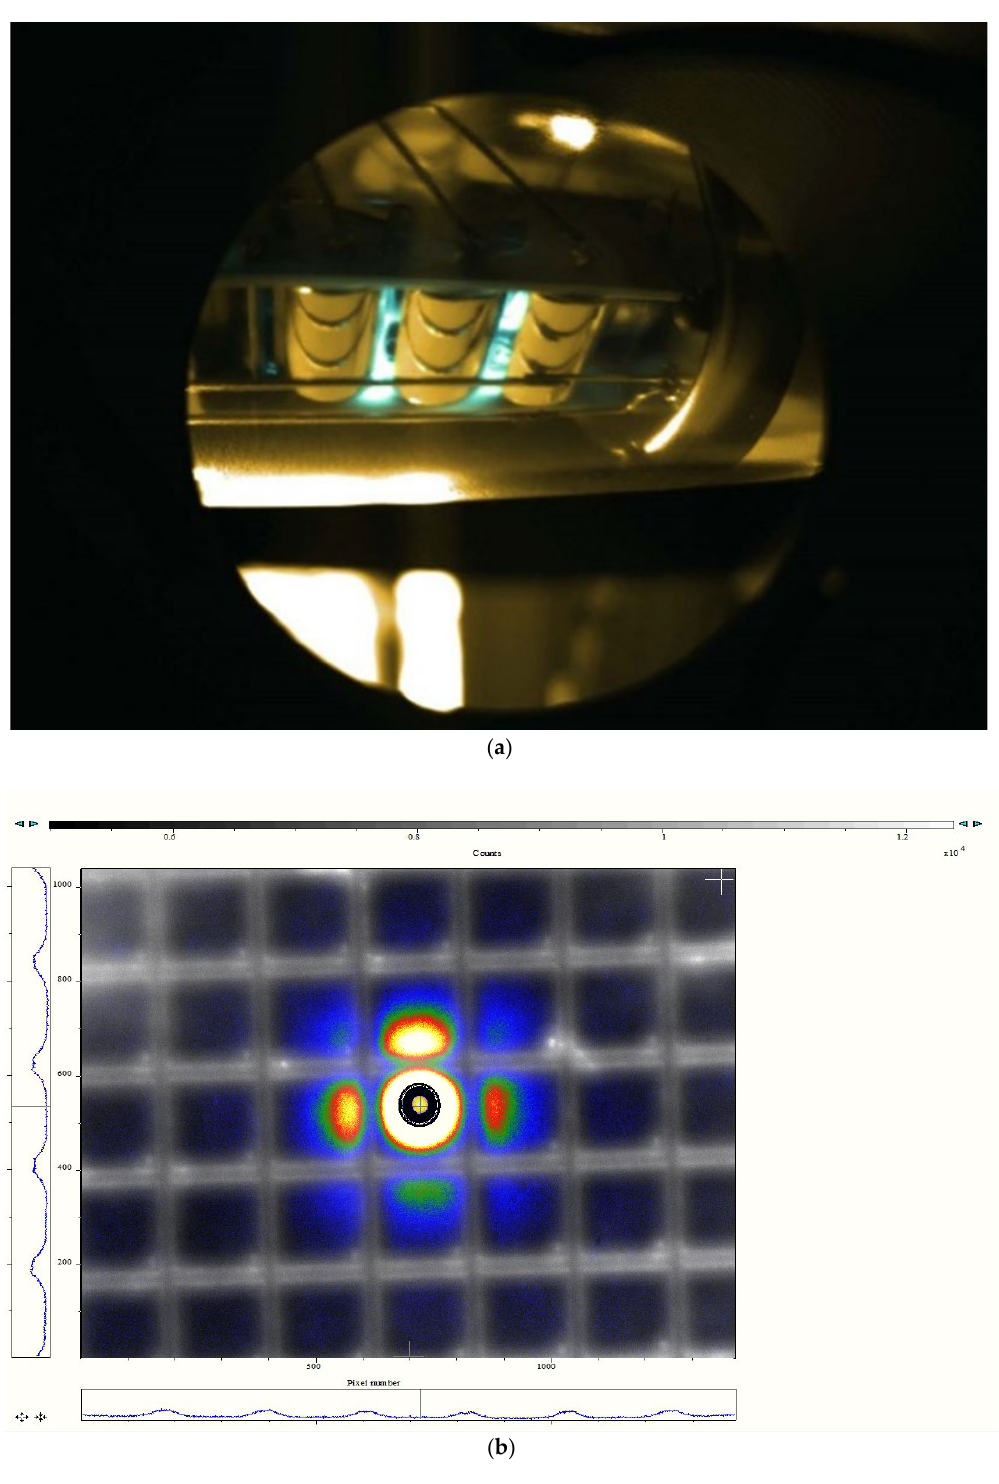
Figure 7. ( a ) This photo shows the light emission leaking through the space between the dynode system of the Hamamatsu R8619 PMT. Part of this light could arrive at the photocathode, causing high-level after-pulsing. Later, the company installed baffles, which reduced the negative effect. See [76] for details. ( b ) Light emission microscopy of a pilot SiPM sample (prod. By B. Dolgoshein and team) under operational voltage. The narrowly focused (<4 µm), weak laser beam shoots at the location of the yellow-black dot on the surface of a 100 µm size cell. One can also see that the neighbor cells emit light. This is the essence of the cross-talk effect; a single incident photon can fire more than one cell.